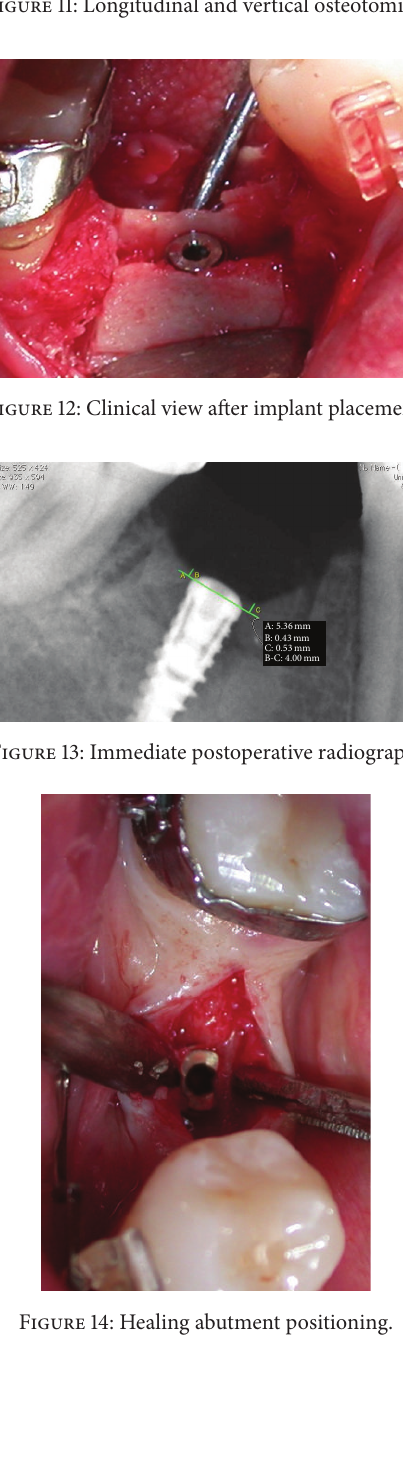
Figure 11: Longitudinal and vertical osteotomies.